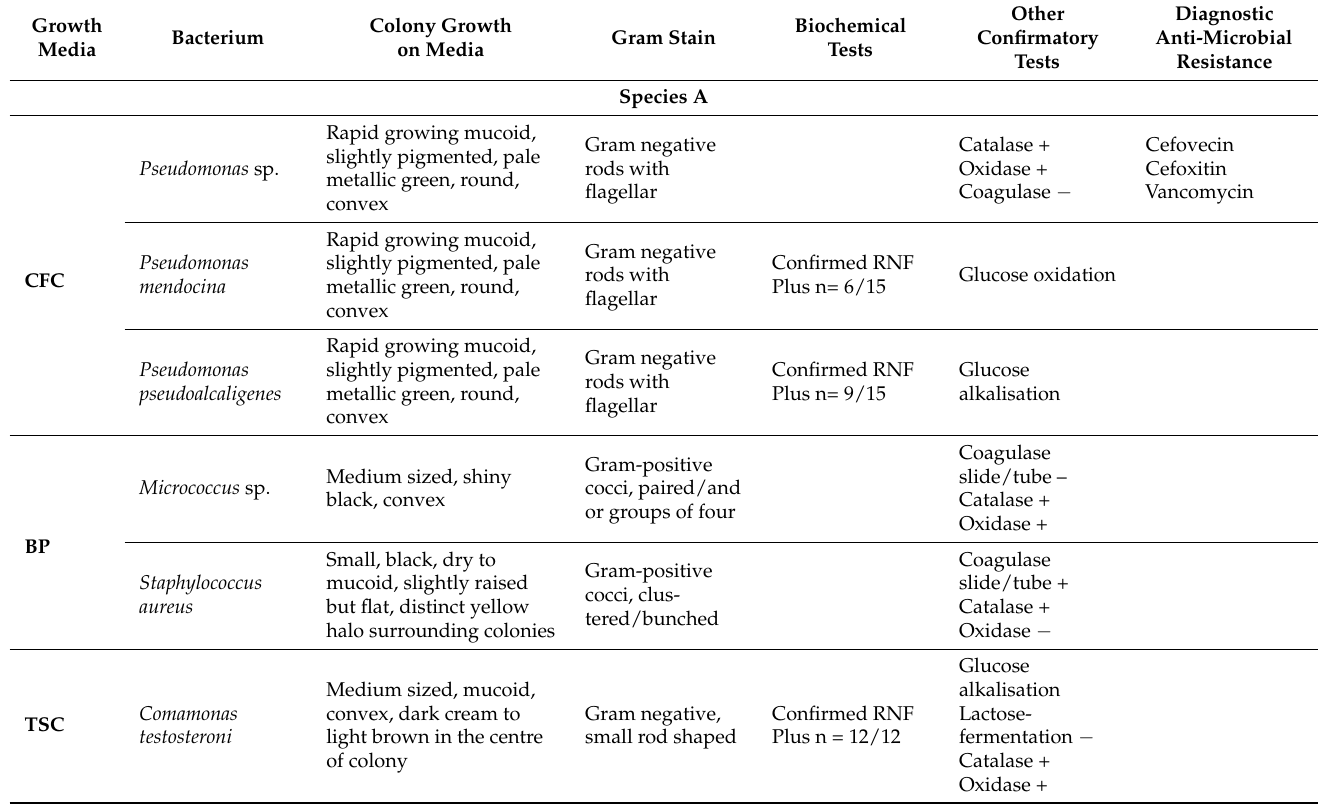
Table 3. Growth media and tests for identification of